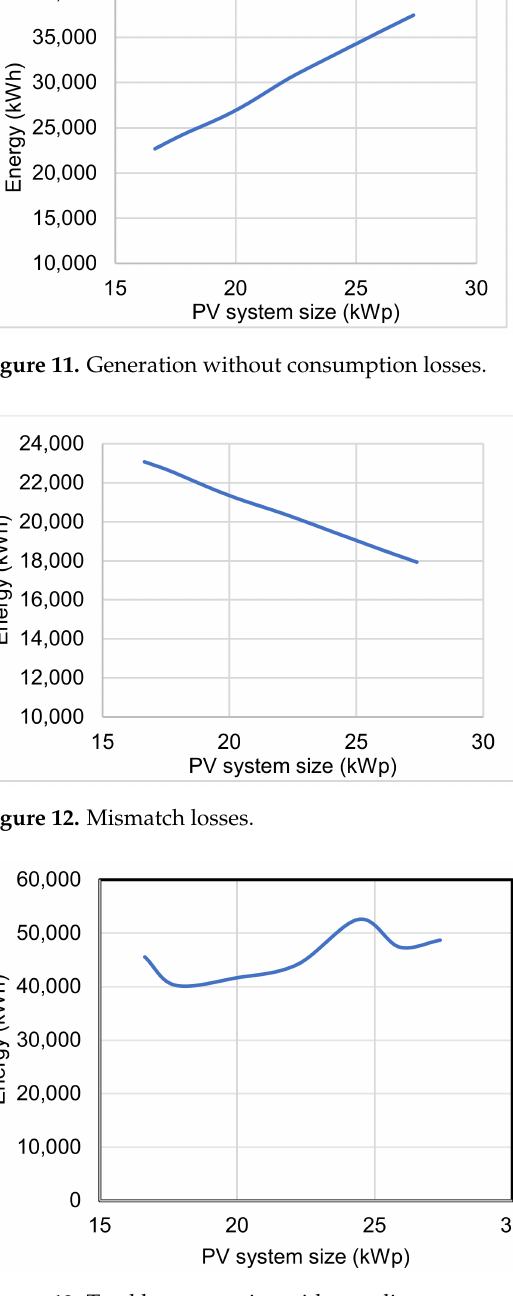
Figure 13. Total losses vs. size with